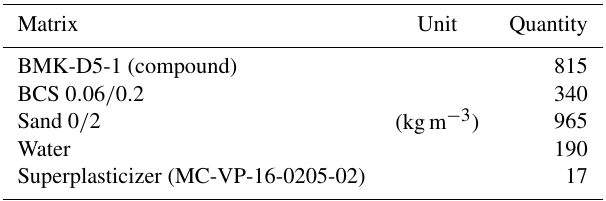
Table 1. Coating materials and fiber specifications. Coating material